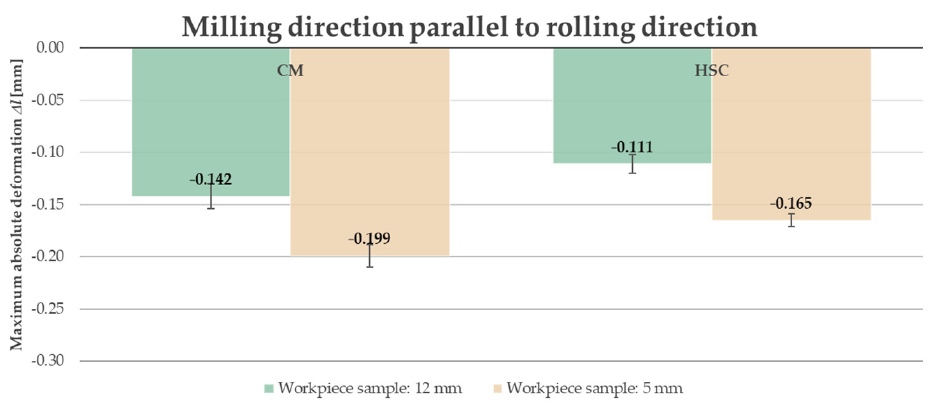
Figure 16. Comparison of the maximum absolute deformations ∆ l depending on the semi-finished product thickness for milling in perpendicular direction to rolling direction.